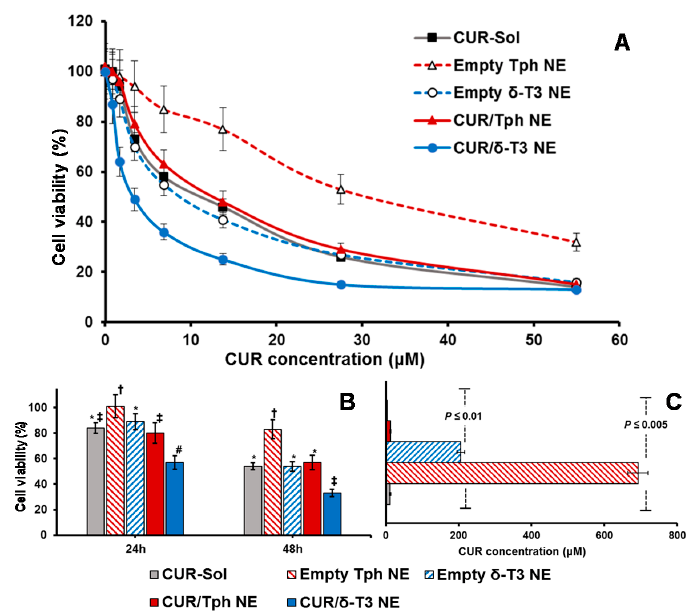
Figure 6. Concentration- and time- dependent cytotoxicity against MCF-7 cell cultures. Microplate- based CellTiter Blue ® assay of human breast carcinoma cells, MCF-7 cells, measured for different empty and CUR-loaded VE- nanoemulsions vs. CUR solution serving as free drug control ( A ) at CUR- equivalent concentration range of 0.85–55 μ M after incubation for 48 h; or ( B ) at “cross-section CUR- equivalent concentration of 25 μ M, over co-incubation period of 24–48 h; along with ( C ) IC 50 values calculated for each preparation type, after 48 h treatment, at 37 °C, 5% CO 2 conditions ( n = 3–4, mean ± SE, mean values denoted with unlike symbols are statistically different, p ≤ 0.05).